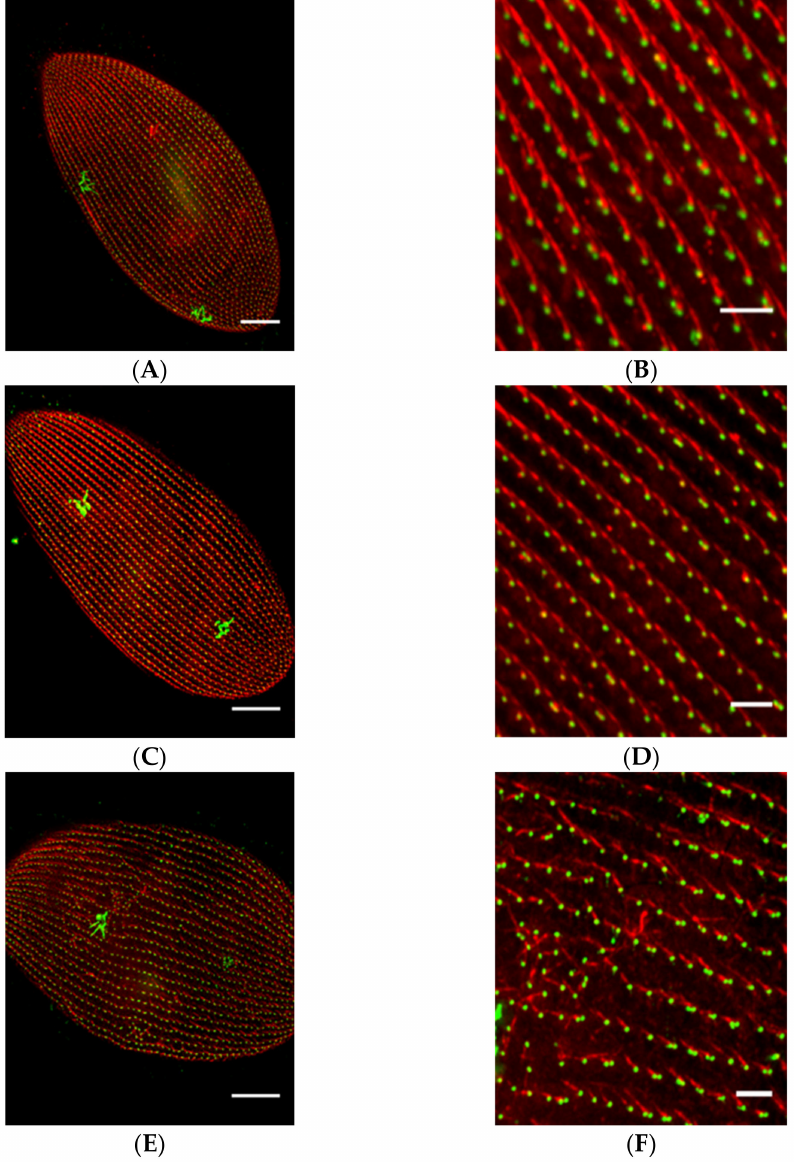
Figure 13. Depletion of MKS5 cause loss of cilia but does not affect the straight basal body rows and Table 1. D5 and anti-SR antibody to visualize the basal body units (green) and SRs (red) respectively on the cell surface. Panels A and B show the basal body row alignment and SRs organization in the control cell. In the control cell basal body rows remain straight and SRs show a highly ordered organization. SR emanates from the basal body unit and extends towards the anterior pole of the cell. Panels C and D show the basal body row alignment and SRs in the MKS5 depleted cells. The phenotype of the cell is similar to the control cell. Panels E and F show the basal body row alignment and SRs in the MKS3 depleted cell. In the MKS3 depleted cell, basal body rows are misaligned and SRs have a disordered organization on the cell surface. Scale bars are 15 µ m in ( A , C , E ) and 3 µ m in ( B , D , F ). Reproduced from [13] with